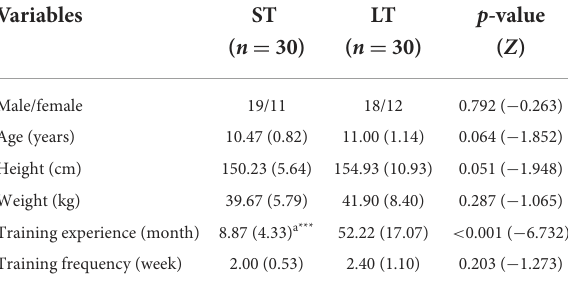
TABLE 1 Demographic characteristics of the study participants.